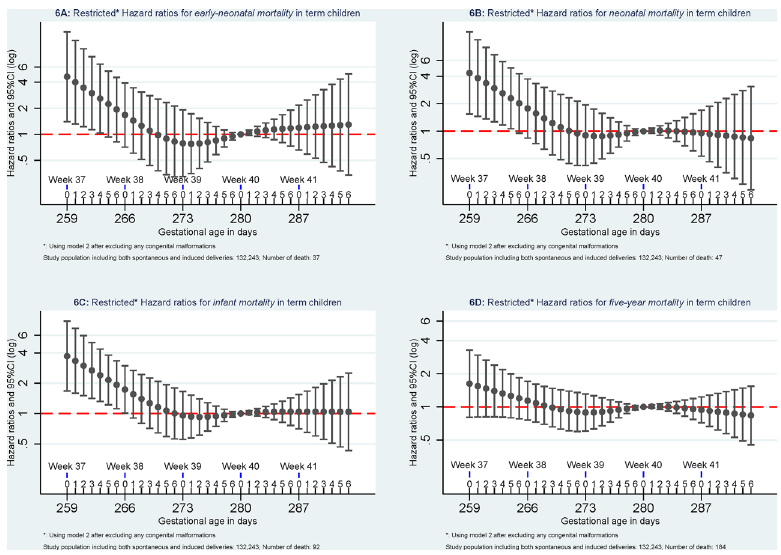
Fig 6. Mortality after excluding pregnancies with any maternal diseases and children with any congenital malformations. The analyses were done using Model 2 and excluding pregnancies without registered morbidity within one year before delivery or within 30 days after delivery and excluding children with any registered congenital malformations.